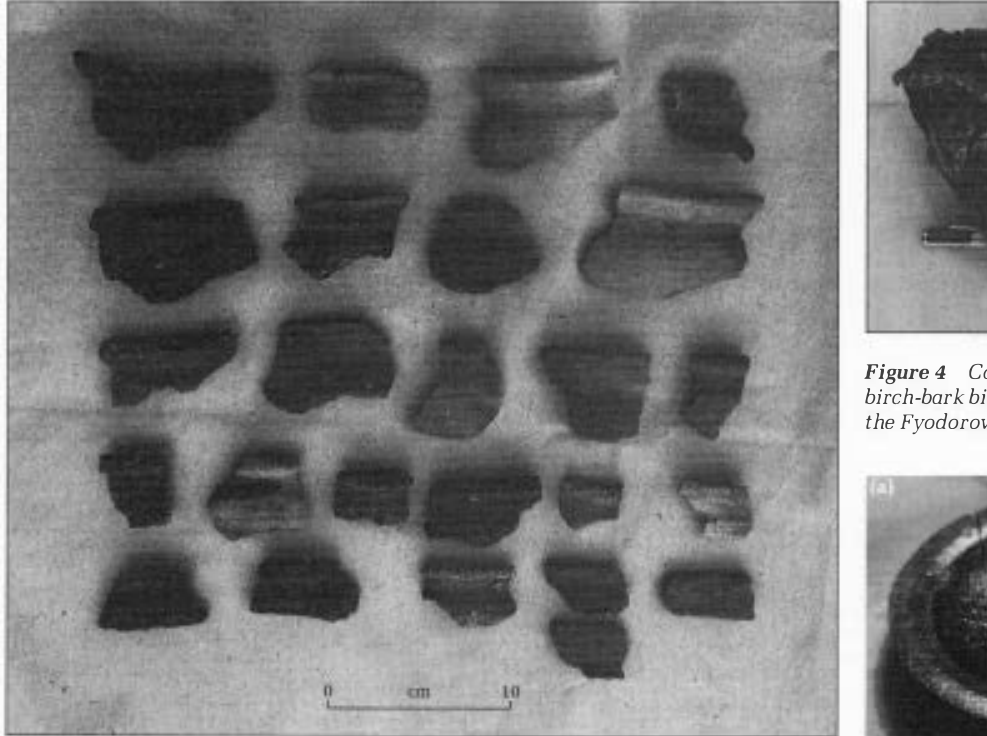
Figure 3 Examples of pottery "wasters" from the Troitsky XI excavation.